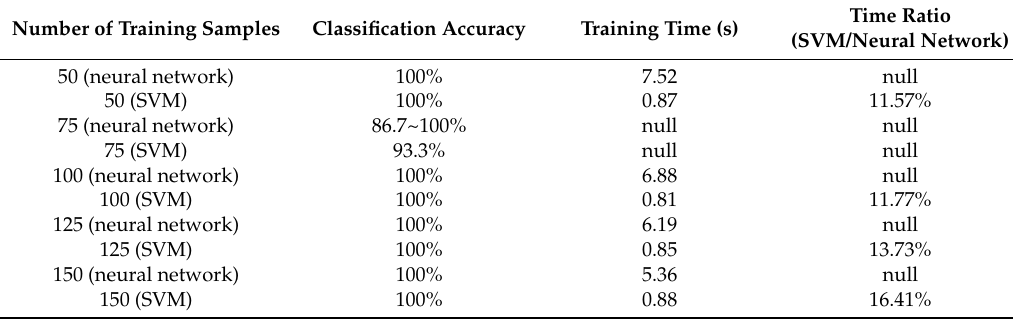
Table 16. Results comparison between neural network and